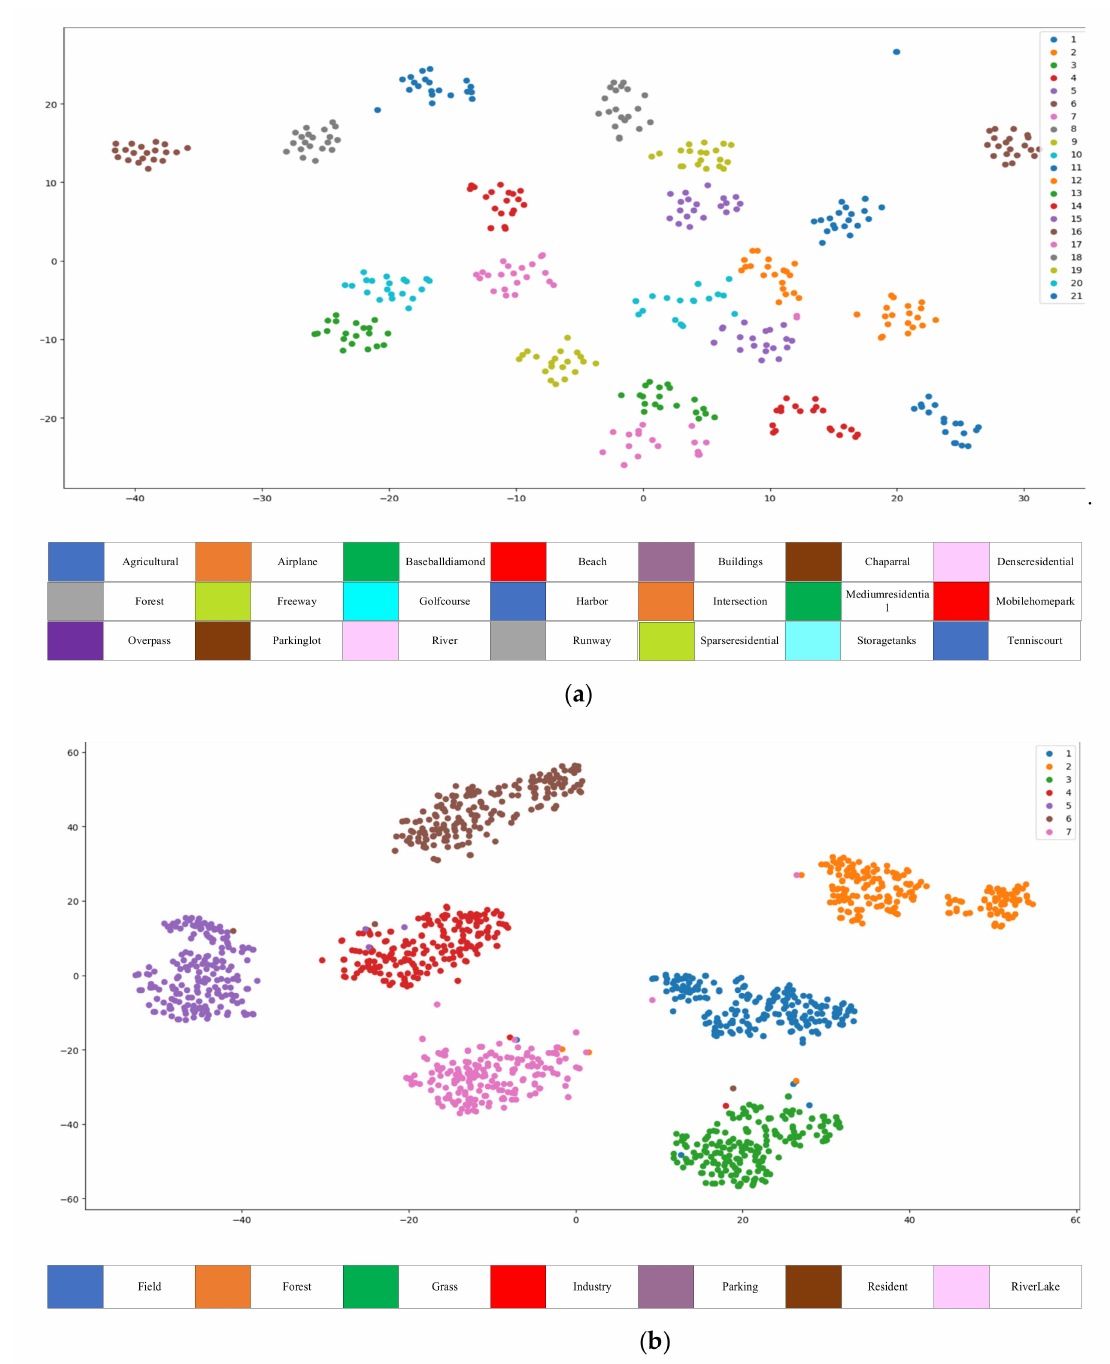
Figure 13. T-SNE visual analysis results. ( a ) The T-SNE visualization results of the proposed method on UCM21 datasets. ( b ) The T-SNE visualization results of the proposed method on RSSCN7